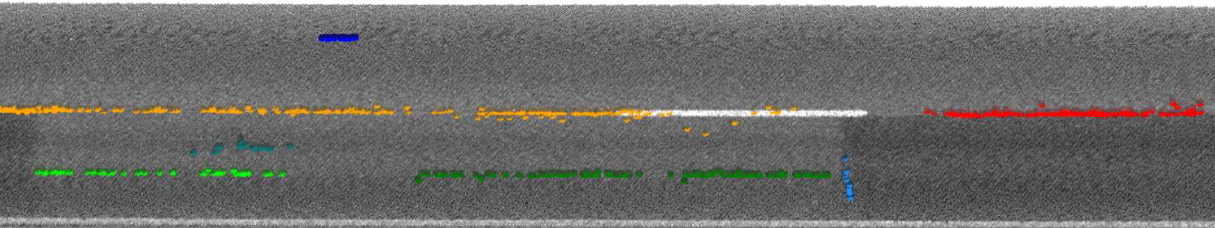
Figure 7. Distance between clusters, defined as the shorter edge connecting their end points (circled in orange). The orientation of the edge is calculated.